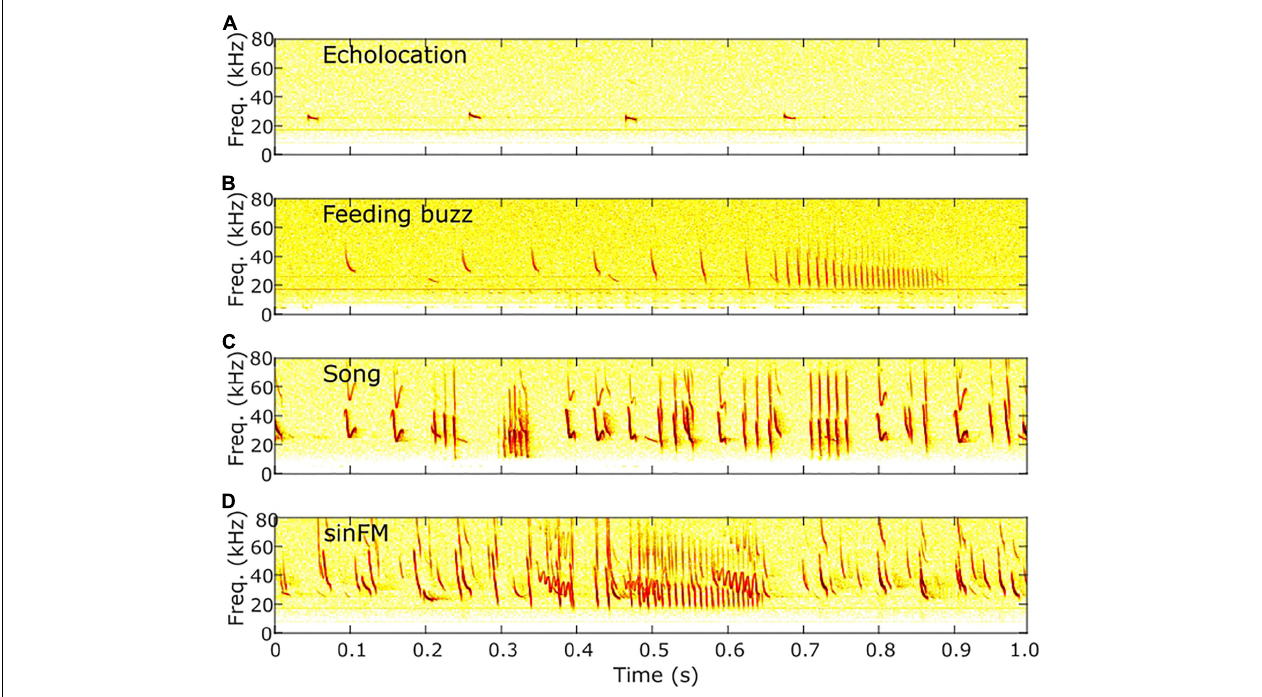
FIGURE 1 | Example spectrograms of acoustic behaviors. (A) Search-phase echolocation calls, (B) approach and terminal phase echolocation calls (“feeding buzz”), (C) Song, and (D) sinFM calls overlapping another bat’s feeding buzz.